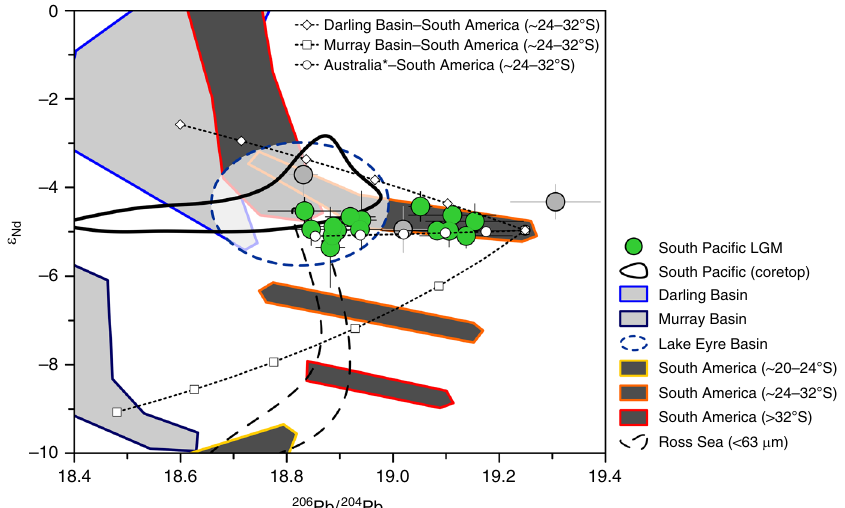
Fig. 4 South Paci fi c Last Glacial Maximum fi ne fraction samples in Pb – Nd isotope space. Last Glacial Maximum (LGM) data points and error bars represent averages and their 2 SD across the LGM interval (~18 – 24 ka BP). The South Paci fi c coretop data include only open ocean locations; samples from the New Zealand and West Antarctic margins 34 , and sample PS75/084-1 are not included (see also Supplementary Note 6). The blue dashed circle approximates the Lake Eyre composition based on the data in Figs. 2 and 3 (see Supplementary Table 3 for references). Mixing between important source regions indicated by stippled lines, white symbols represent 20% increments. Australia* re fl ects the endmember composition as described in the main text. See Supplementary Table 2 for more details and Supplementary Table 3 for references to literature data. It is noteworthy that South Africa and New Zealand (overlap with Lake Eyre Basin) are not included here (see “ Discussion ” and Supplementary Note 2 and Supplementary Table